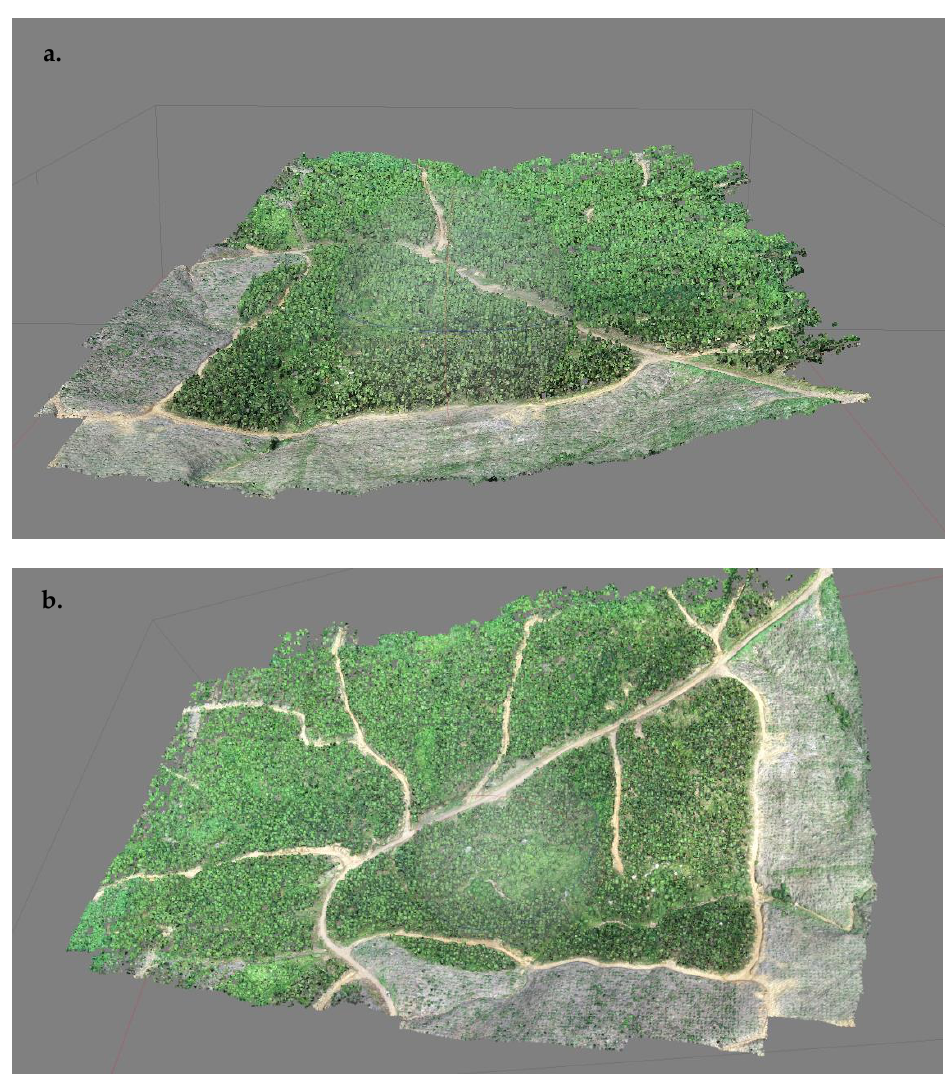
Figure 3. Point cloud densification of Block 42H. ( a ) Oblique view. ( b ) Vertical view. Table 4. Volume of the biggest generated Geomatic